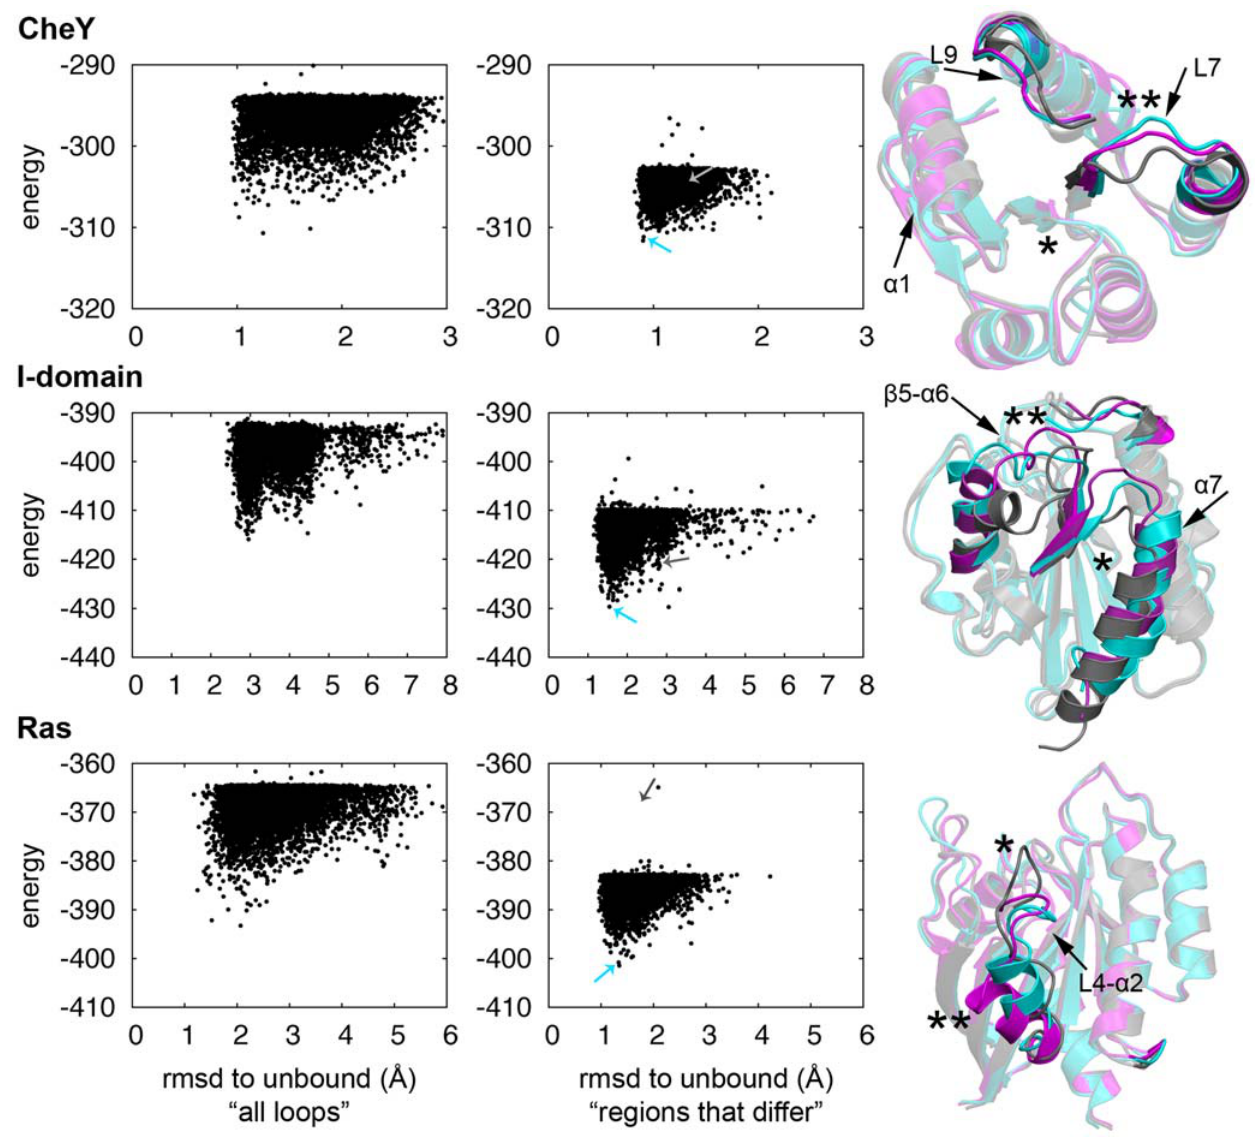
Figure 1. Rosetta predictions of conformational change in the allosteric proteins CheY, the a L I-domain, and Ras. The Rosetta all-atom energy is plotted against C a -rmsd for models generated by simulations starting from the native conformation in the bound state with the allosteric effector removed from the crystal structure. Left panel shows the rmsd comparison to the alternative crystal structure when all loops have been remodeled, the center panel, the rmsd comparison to the alternative crystal structure with remodeling of loop or secondary structure regions that differ between the states. Arrows indicate the locations of the starting structure (gray) and lowest-energy model from the cluster with the largest number of structures (cyan). Right panel shows the superposition of the lowest-energy model taken from the largest cluster in the center panel (cyan) to the starting (gray) and alternative (magenta) crystal structures. The allosteric effector and protein binding site are indicated by * and ** respectively. The bright regions indicate regions that differ the most between the two crystal structures and were remodeled, while remaining regions are faded. Black arrows indicate the regions in the lowest-energy model that have moved toward the alternative state. doi:10.1371/journal.pcbi.1000484.g001 In addition to identifying low-energy structures that are near the alternative conformation than the initial structure, and energy crystal conformation of the unbound state, subregions with the versus rmsd plots reveal an energy minimum at the unbound largest conformational difference between states were predicted to conformation (center panel of Figure 1). Additionally, the largest within an accuracy of between 0.3–3.4 A˚ (C a -rmsd) to the cluster of the 20 lowest-energy structures contained at least 4 alternative state (indicated by black arrows in Figure 1, and Table models, suggesting that sampling is converging toward the S1). The structural changes in CheY involve a shift of helix a 1 and alternative conformation. That is, with the specification of the rearrangements of the loops L7 & L9 near the FliM binding pocket regions in which major conformational changes take place, the (indicated by **). Removal of a disulfide bond (allosteric effector rebuild and refinement protocol can sample the alternative state indicated by *) in the a L I-domain that mimics the activated state and the energy function has sufficient accuracy to distinguish the allows the a 7 helix to shift upward more than 6.5 A ˚ and the loop unbound state based on its lower energy.